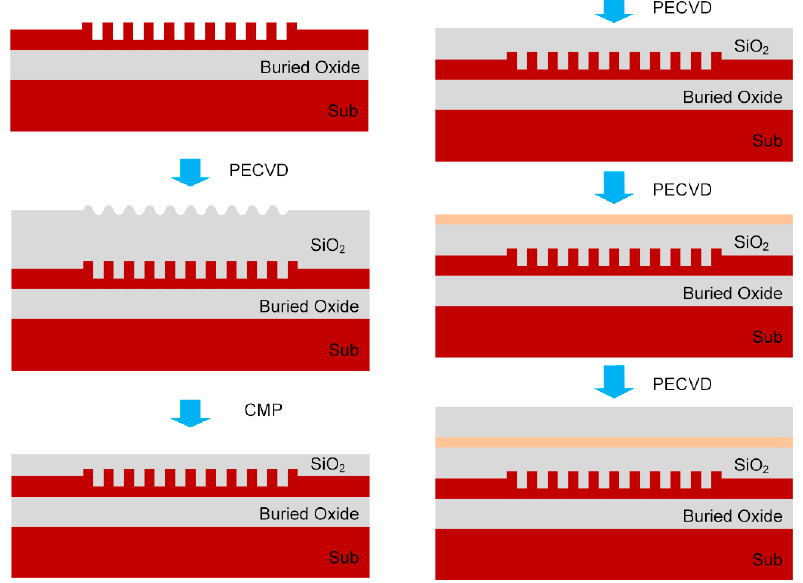
Figure 8. Process flow of the Si 3 N 4 reflector over the grating for the Fabry-Perot-like cavity.